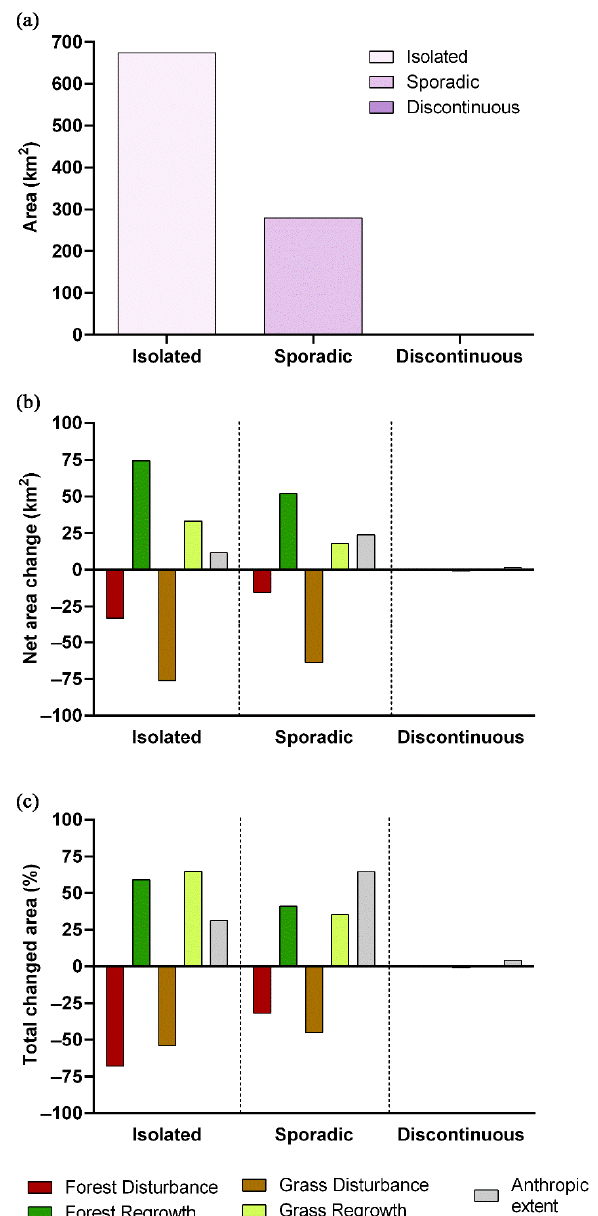
Figure 5. ( a ) The overall area (km 2 ) of isolated, sporadic, and discontinuous permafrost in the Hola Basin, Northeast China, after Obu et al. [31]; ( b ) the net change of classes area in km 2 for the period 2000–2019, and ( c ) the net change of classes area in %.